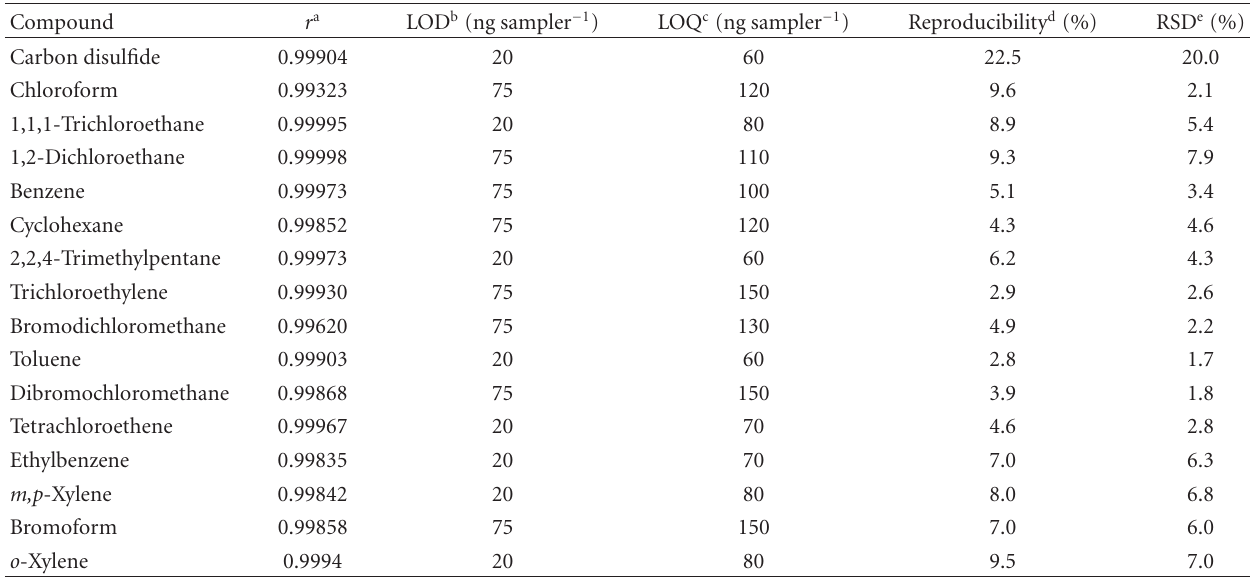
a Correlation coe ffi cients. b Limit of detection.